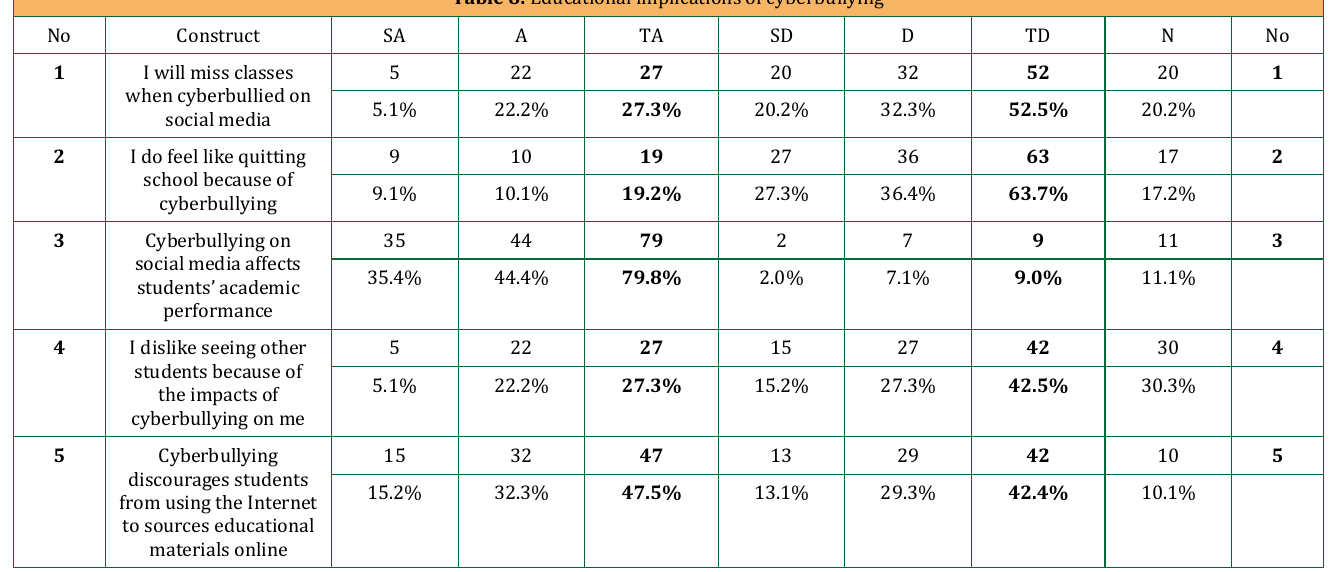
Table 8: Educational implications of